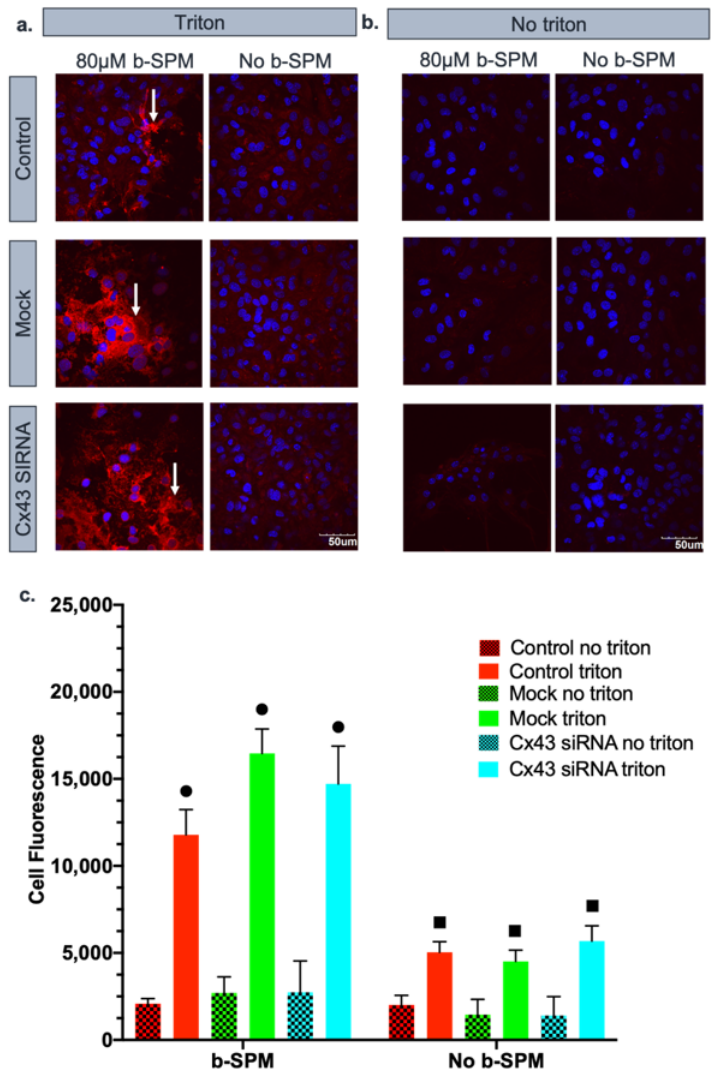
Figure 2. Biotinylated spermine (b-SPM) is taken up into astrocytes. Rho-avidin was used to visualize b-SPM (red), and DAPI was used to visualize the nuclei (blue). The presence of b-SPM presence is marked with the white arrows. ( a , b ) Qualitative representation of the data. Control, mock (only treated with HiPerFect), and Cx43 siRNA-transfected astrocytes were incubated in either 80 µ M of b-SPM and no b-SPM (PBS) in the presence or absence of triton. No triton and no b-SPM samples were used as negative controls. Calibration bar is the same for all images (50 µ m). ( a ) When the membrane was permeabilized with triton, b-SPM was detected in the cytoplasm of the astrocytes in control, mock, and siRNA Cx43 (see white arrows). ( b ) When the membrane was not permeabilized with triton, only minimal fluorescence was seen, indicating that b-SPM was not adhered to the extracellular side of the astrocytic membrane. ( c ) Quantitative representation of the data ( n = 3/group). Black circles represent ( • ) statistical difference ( p < 0.05) between the triton and no triton samples. Black squares ( (cid:4) ) represent statistical difference ( p < 0.05) between b-SPM and no b-SPM samples. There was no statistical difference between mock triton and Cx43 siRNA